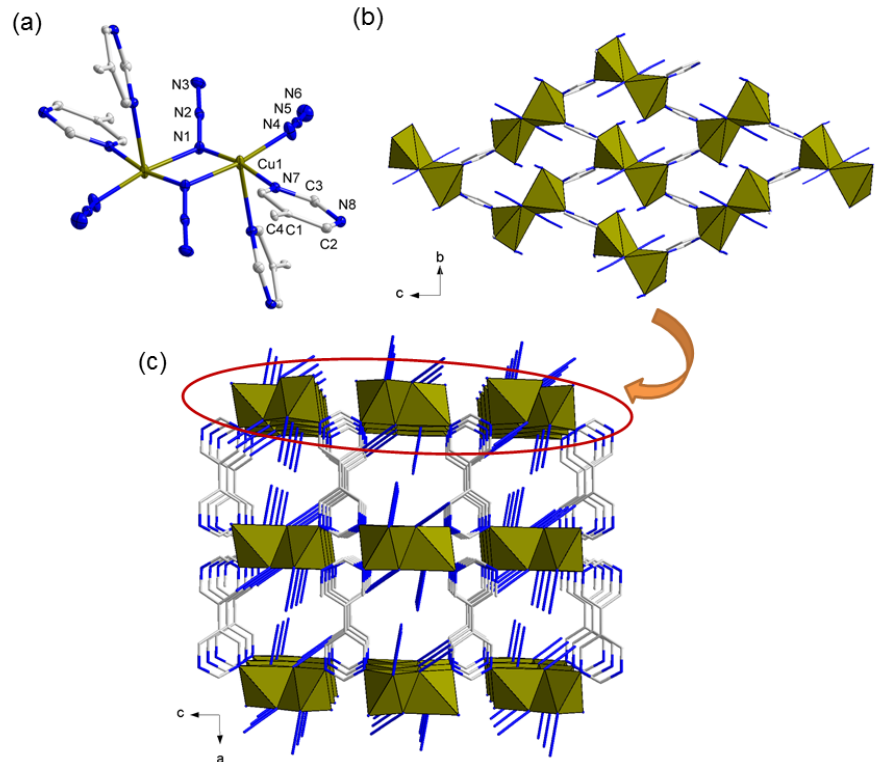
Figure 3. ( a ) The local coordination environment of Compound 2 ; ( b ) the 2D Cu 2 -pym layer; ( c ) the pillared-layer 3D structure of 1 . The H atoms of the bpym ligand have been omitted for clarity.